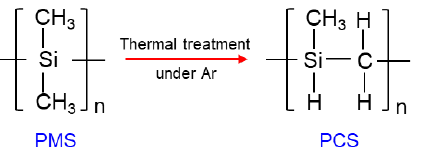
Figure 16. Schematic illustration of the conversion reaction of PMS to PCS.